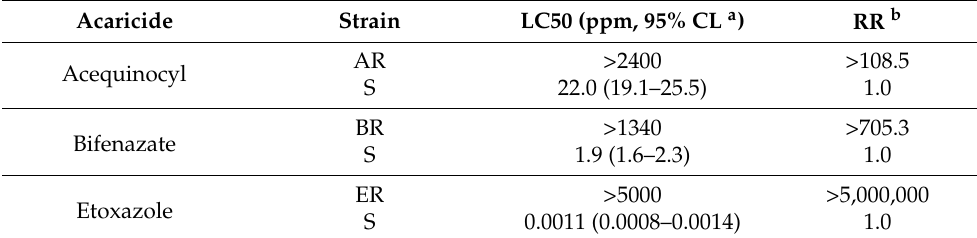
Table 1. Resistance ratio of T. urticae against three types of acaricides. Acaricide